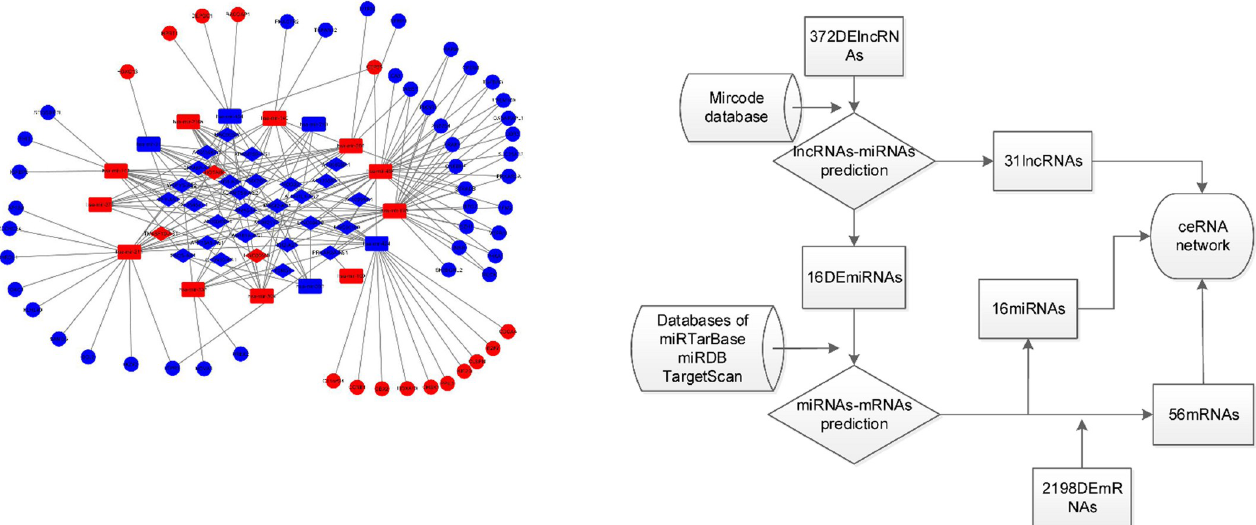
Fig 2. (A) The ceRNA regulatory network in OFSCC. The nodes highlighted in red indicate expression up-regulation, and the nodes highlighted in blue indicate expression down-regulation. LncRNAs, miRNAs and mRNAs are represented by diamonds, rounded rectangles, and squares, respectively. (B) A Flow chart for ceRNA network. ceRNA: competitive endogenous